Question: Does the plotted quantity increase or decrease?
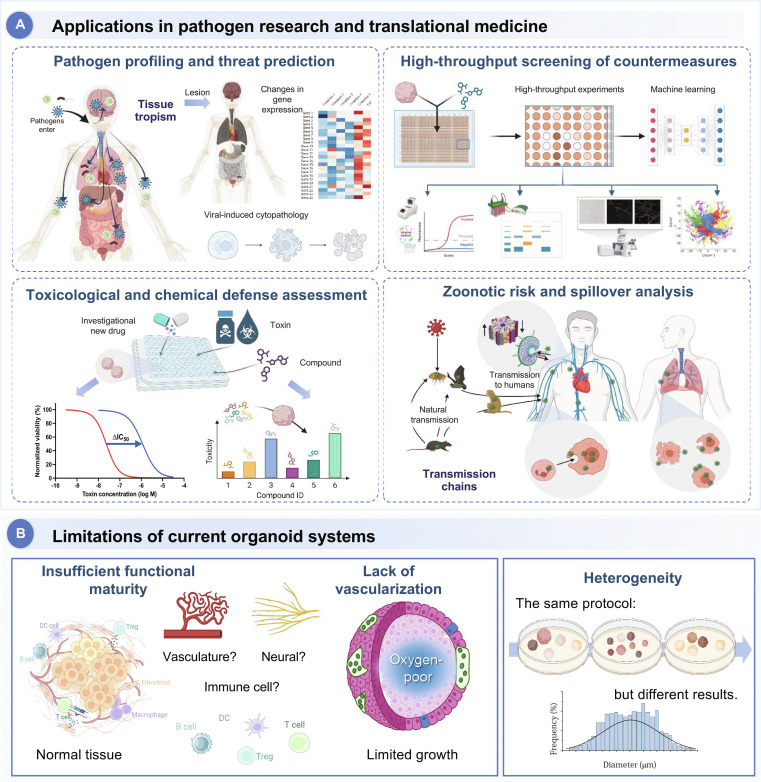
Answer: increasing